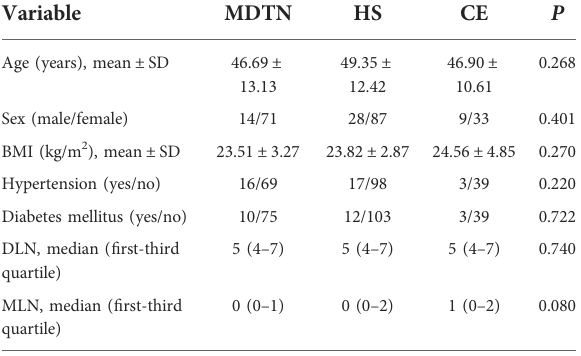
TABLE 1 Baseline characteristics of the patients.